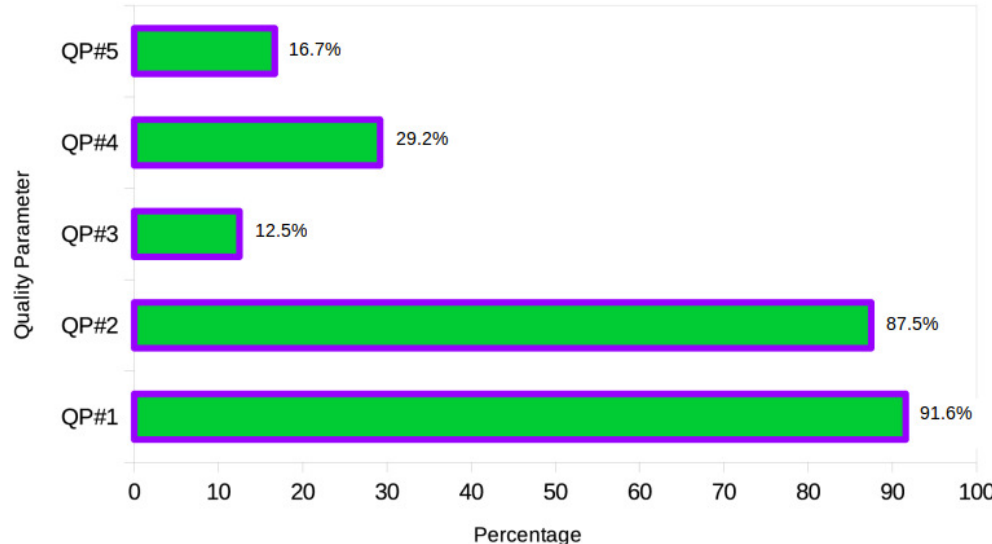
Figure 4. Bar-graph plot: Level of impact caused by the quality parameters QP #1 to QP